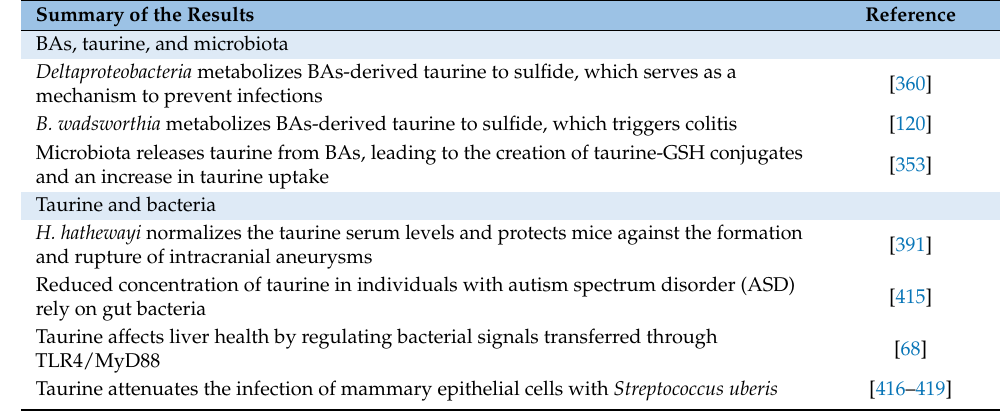
Table 1. Direct evidence on the physiological consequences of the interaction of BAs, taurine, and microbiota or taurine and